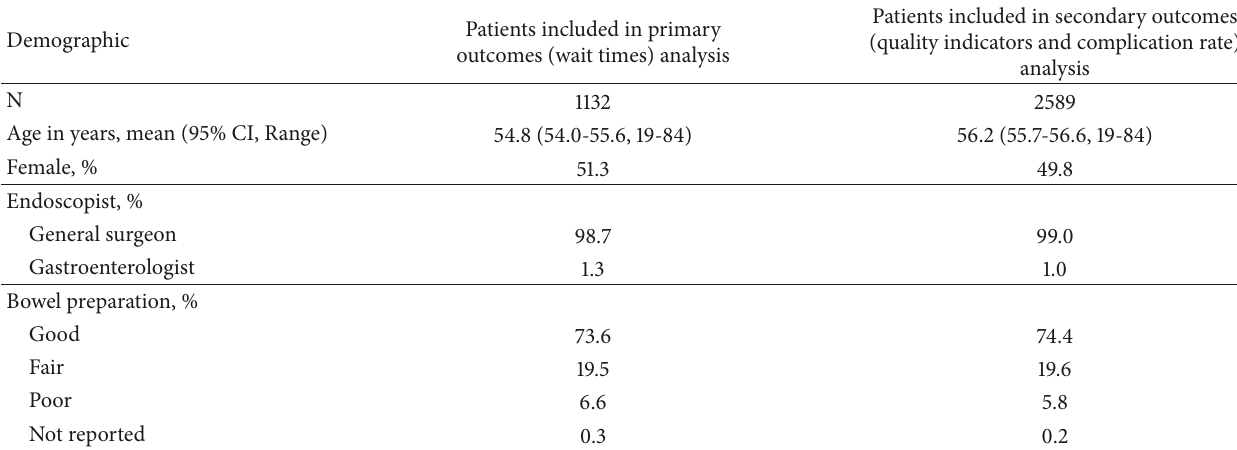
Table 1: Patient